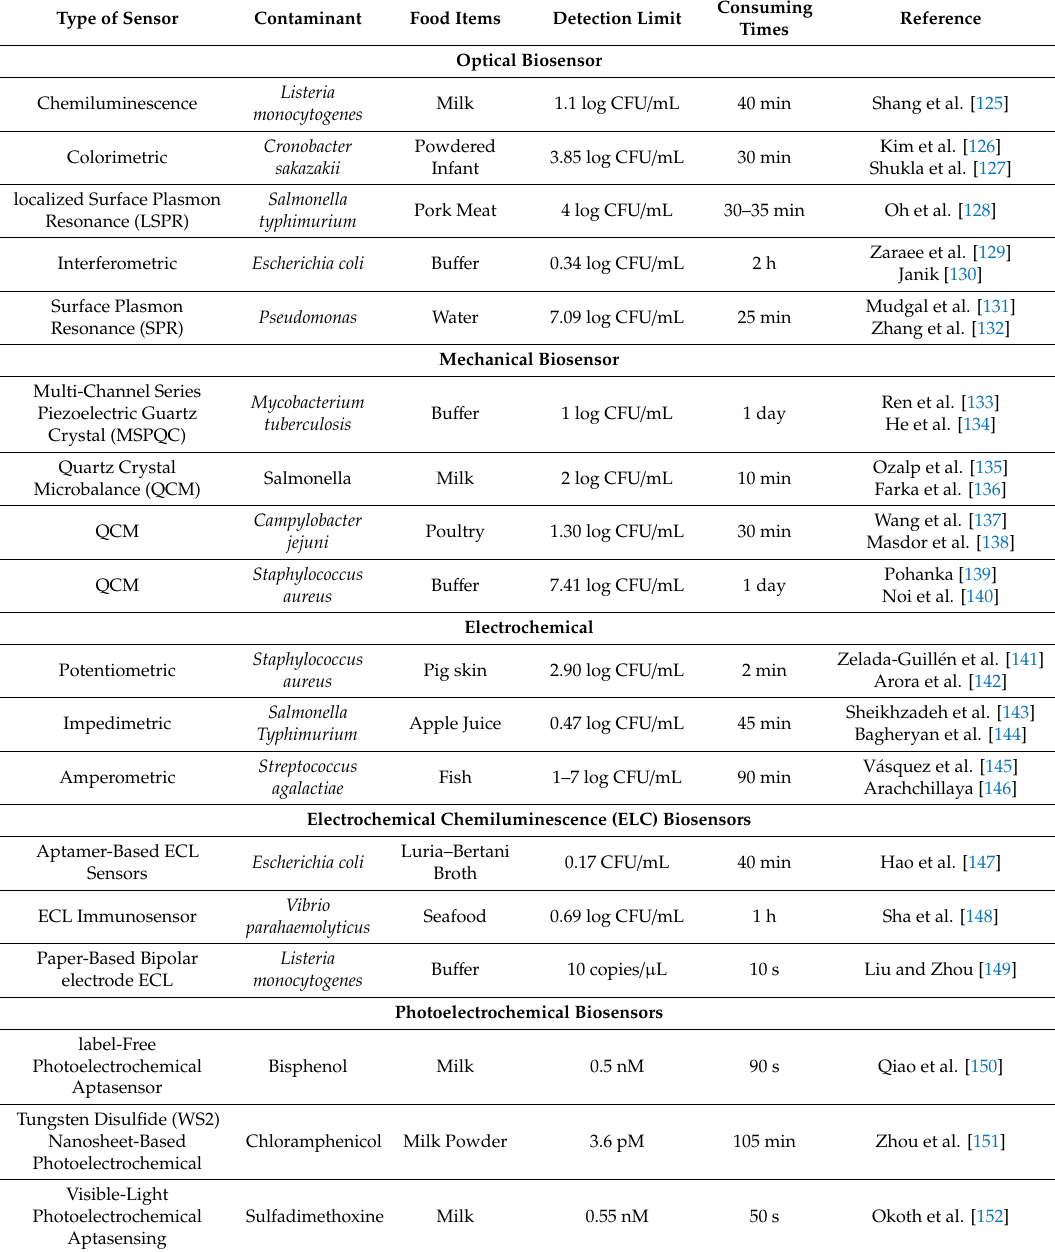
Table 3. Newly Created Biosensors for the Identification of Various Contaminants in Food